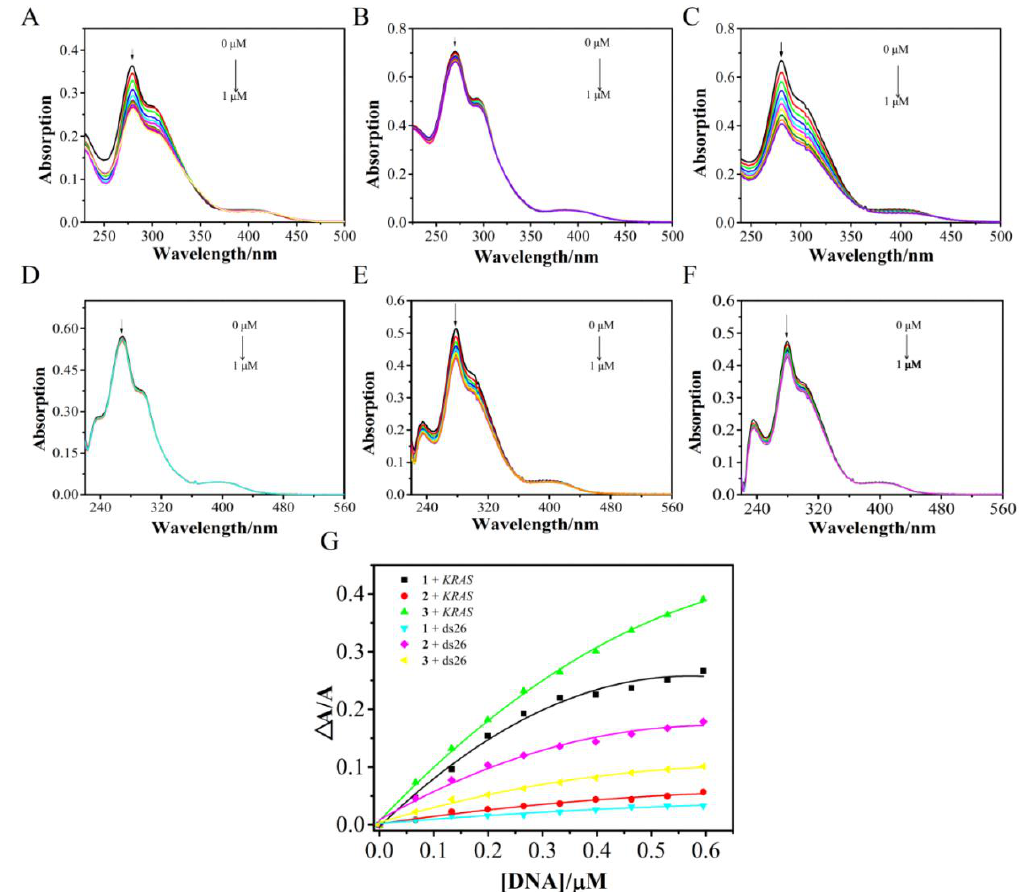
Figure 2. The electronic absorption spectra of complexes 1 , 2 , and 3 interacting with ( A – C ) KRAS G-quadruplex DNA; and ( D – F ) ds26 DNA. ( G ) ∆ A/A vs. [DNA], ∆ A = A 0 −